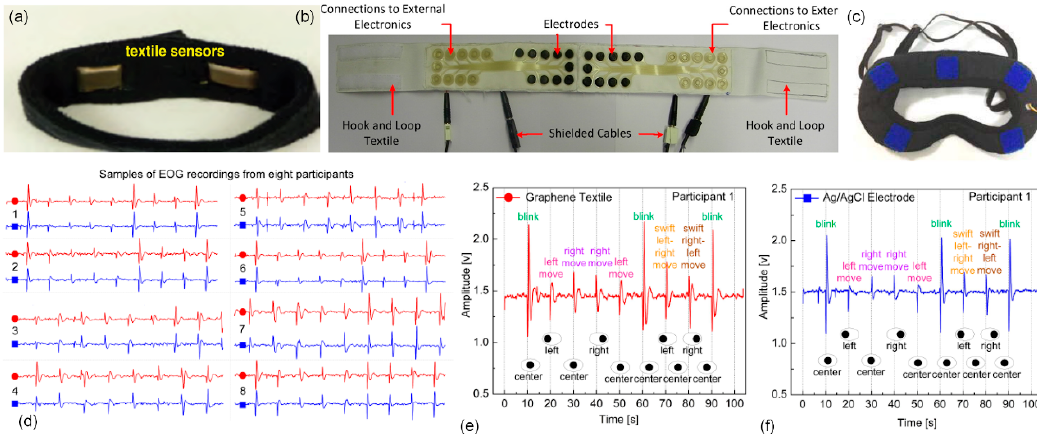
Figure 7. Wearable elastic garments; ( a ) headband developed for gesture recognition [119]; ( b ) headband used for horizontal electrooculography (EOG) acquisition [80]; ( c ) eye mask developed for sleep monitoring [120]; ( d ) subset of electrooculography recordings obtained using graphene textile and Ag/AgCl electrodes that displayed the highest correlation of 87% for a 95 s recording in 2 trials on 8 different participants. Zoom-in view of EOG signals showing the unique eye movement patterns acquired from participant 1 using ( e ) graphene textile electrodes; and ( f ) Ag/AgCl electrodes [121].